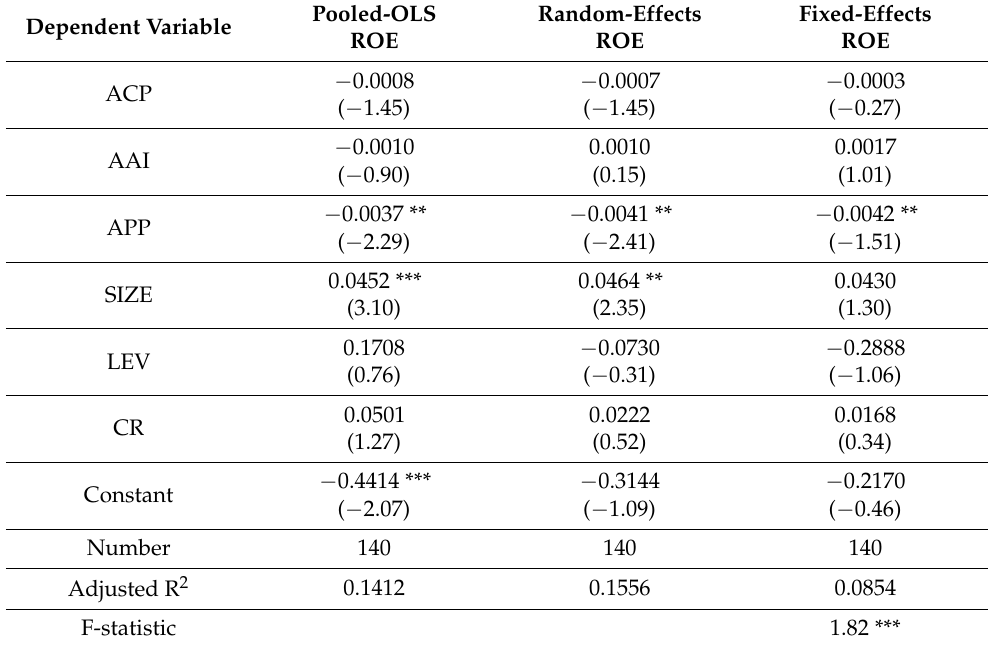
Table 5. Panel regression results with ROE as the dependent